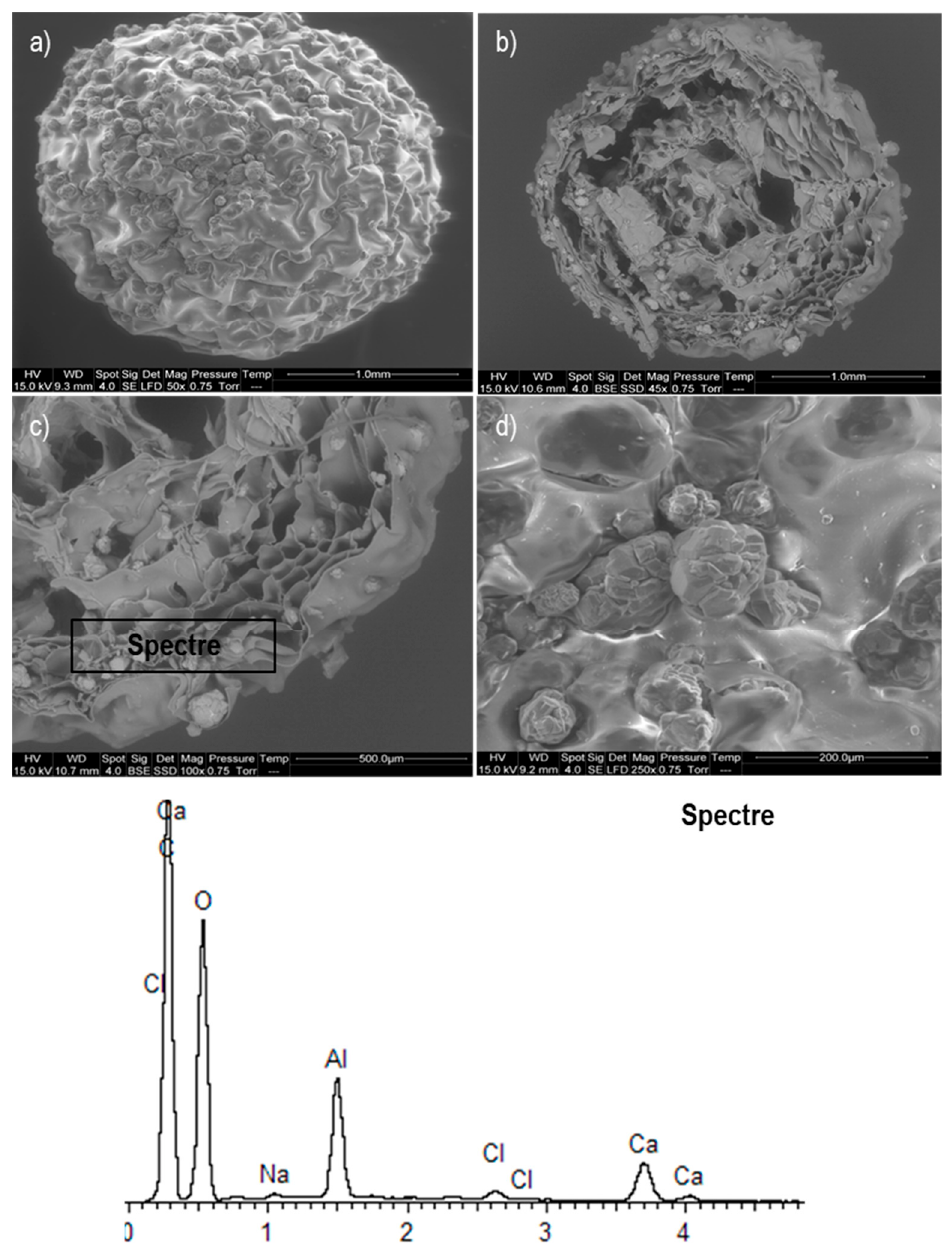
Figure 1. Scanning Electron Microscopy (SEM) images of the CAAl material: ( a , b ) Topography of the sorbent; ( c ) Energy Dispersive X-ray (EDX) analysis on the surface area of the sorbent, ( d ) Alumina particles immobilized in the alginate support.